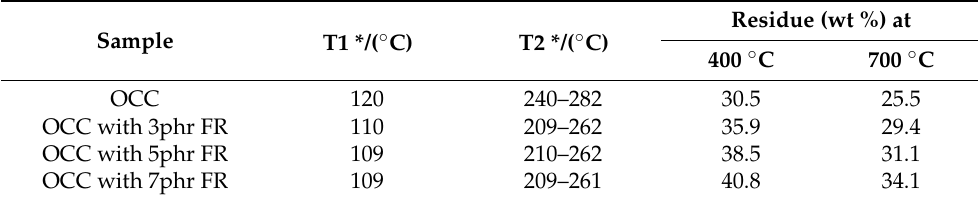
Table 2. Results from TGA of OCC with and without FR